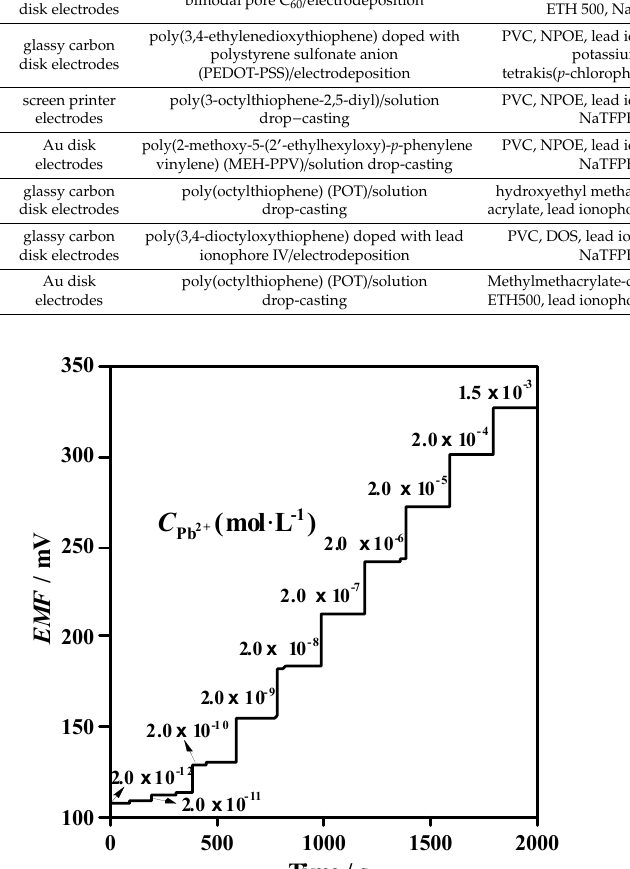
Figure 4. Dynamic potentiometric response of Au / MWCNTs / (MMA-BA)-Pb 2 + -ISEs with increasing